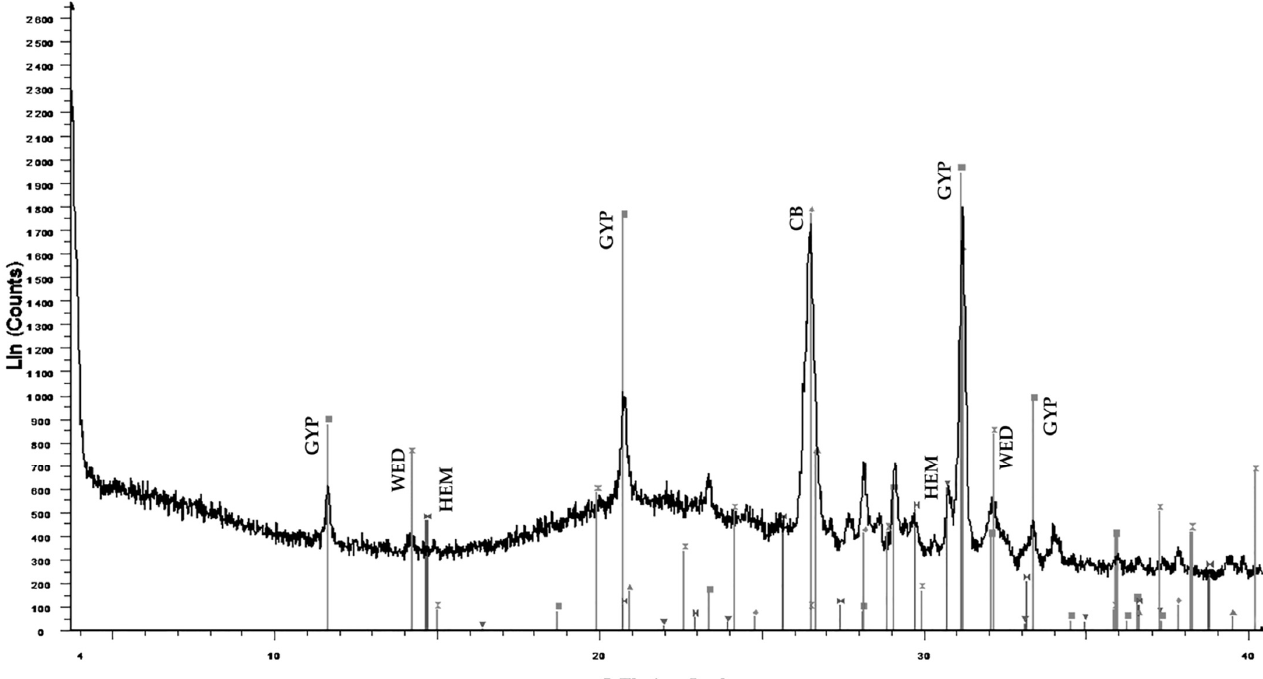
Figure 8. PD-III diffractogram showing gypsum (GYP), hemihydrate, dolomite (DOL), weddellite (WED), and cinnabar (CB) minerals. Modern Polychromies PD-I. Fine gold in yellow of chromium and lead: Chromium yellow is a synthetic mineral pigment used throughout the 19th century [66], after the construction of the